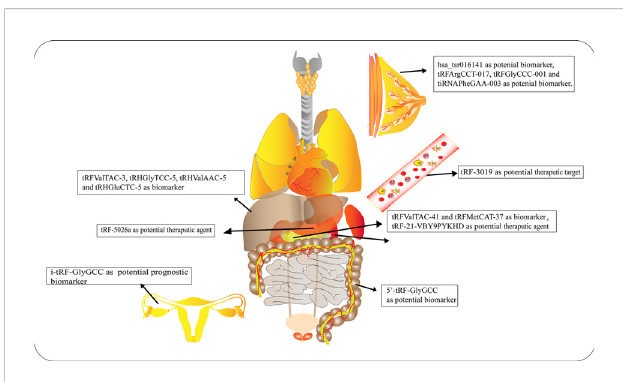
FIGURE 4 Roles of tRNA-derived fragments (tRFs) in various cancers. Different types of tRFs could serve as various biomarkers or therapeutic targets for distinct cancers or potential therapeutic agents.